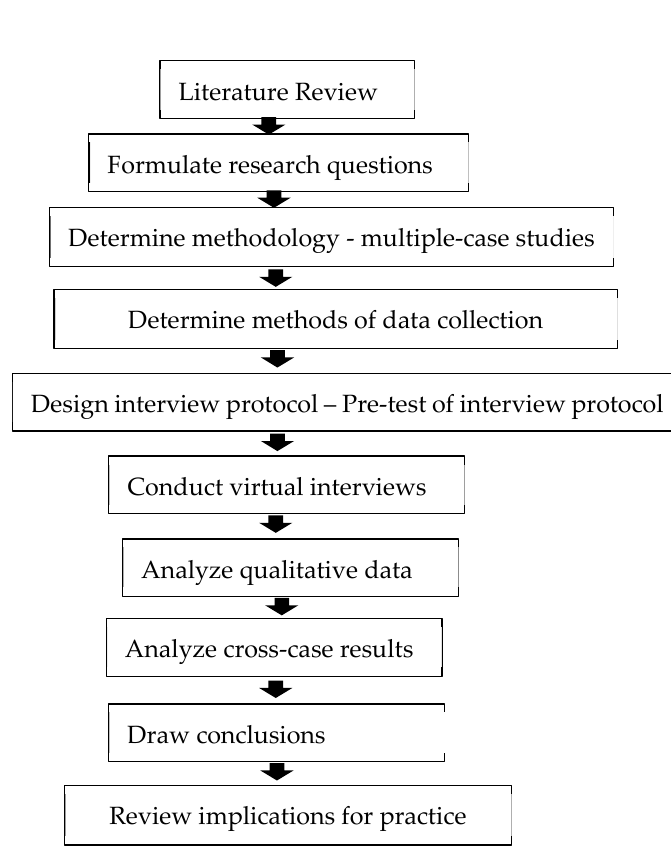
Figure 2. Research Design of the study developed in this paper.